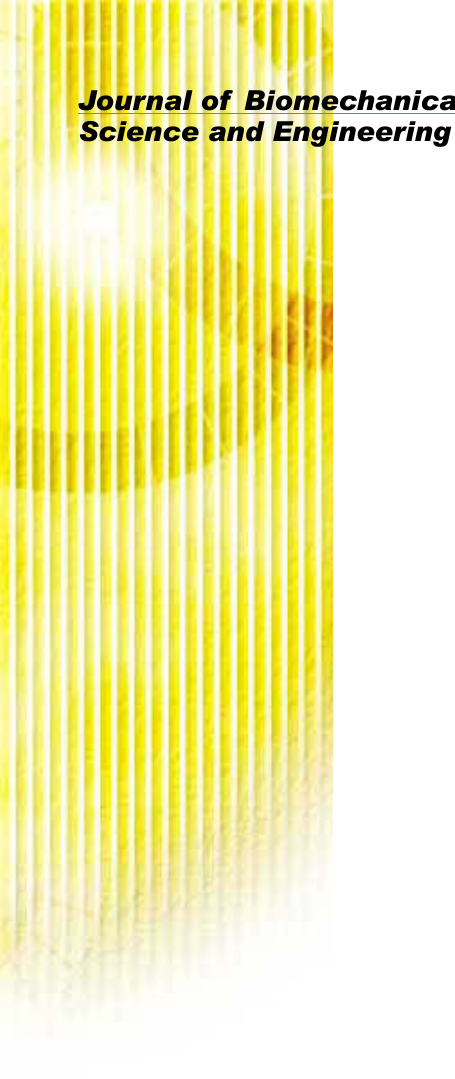
Fig. 6 Time course of average peak-to-peak of contraction force during the electrical stimulation at a stimulation frequency of (a) 2 Hz, (b) 5 Hz, (c) 10 Hz, or (d) 20 Hz. Resting times was inserted between ESs with a duration of 0 s (black dot), 10 s (white lozenge), or 20 s (gray triangle). The data is represented as an average for 1